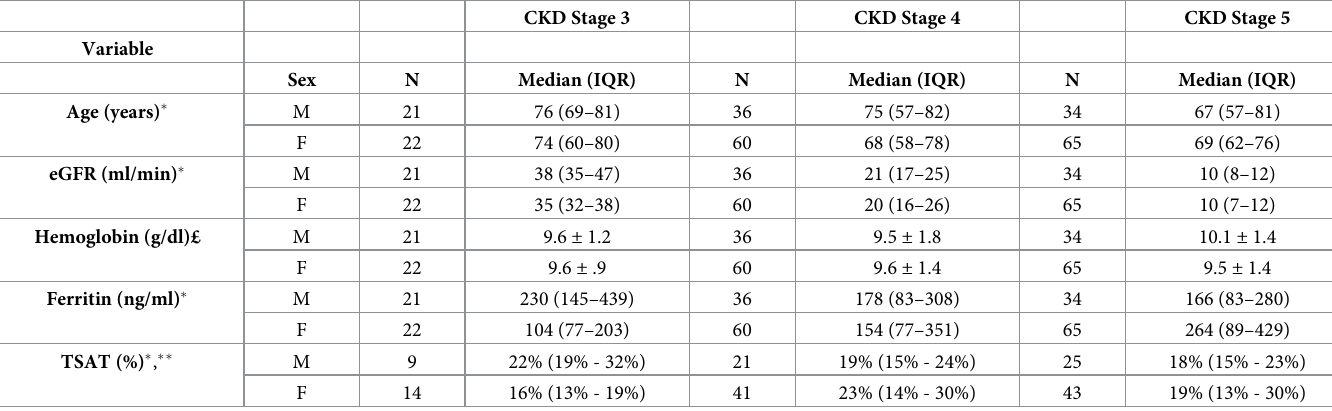
Table 2. Characteristics of the 238 patients by gender and CKD stage.